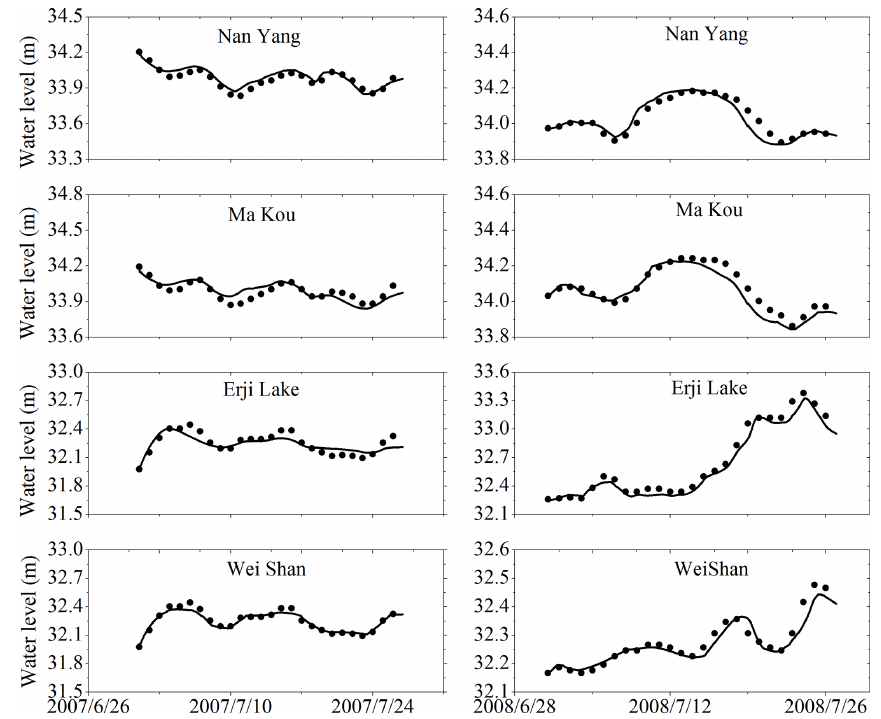
Figure 4. Comparison of the observed and simulated water levels at the selected locations for 2007 flood events under calibration conditions (left) and 2008 events under validation conditions (right). Black dots represent observed data, and black lines represent model simulation results.